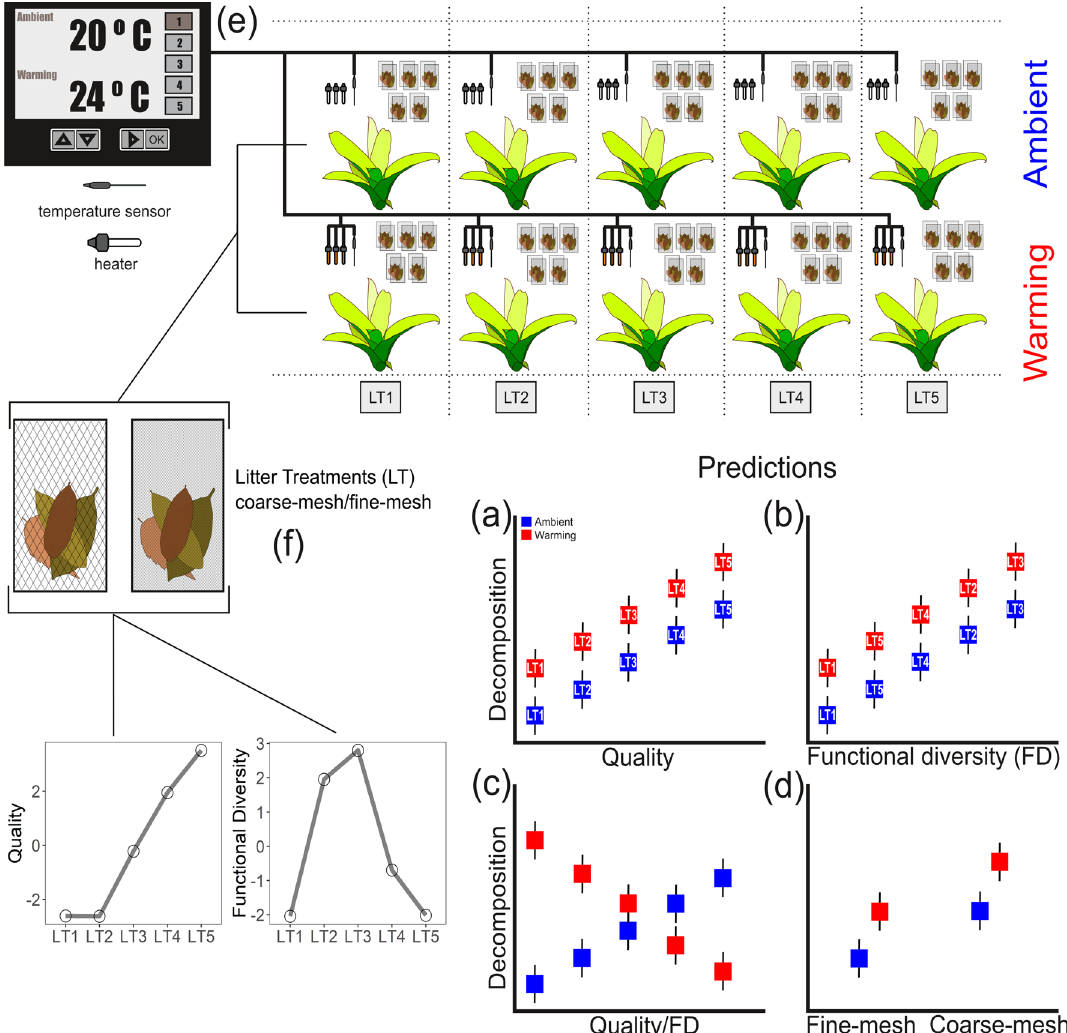
Figure 1. Schematic representation of the experimental design, temperature control system and main predictions. Based on quality hypothesis ( a ), decomposition should increase with litter quality; however, functional diversity hypothesis ( b ) assumes that decomposition increases with higher litter trait dissimilarities. Moreover, warming should exacerbate such relationships by accelerating microbial activity and macroinvertebrate consumption rates. ( c ) Alternatively, warming could affect decomposition rates by interacting with the different levels of quality or functional diversity. ( d ) Decomposition rates are expected to be higher in the coarse-mesh bags and warming may exacerbate the effect; alternatively, warming could decrease litter decomposition in the coarse-mesh bags by negatively affecting macroinvertebrate composition. ( e ) Experimental design: ten tank bromeliads per block (five blocks). Warming effect was achieved by increasing ambient temperature in 4 °C, following the projection for the year 2100. ( f ) Litter treatments (LT) consisted of five mixtures of four out of twelve litter species selected based on their chemical traits, ranging from low to high quality, using coarse and fine-mesh bags. In addition, these litter treatments represented a gradient of functional diversity (see Fig. 2 on how we assessed quality and functional